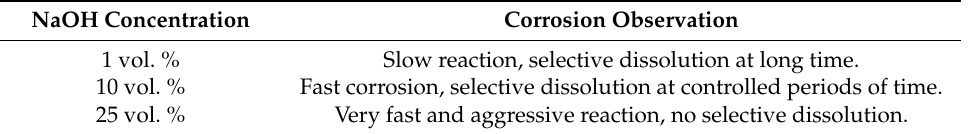
Table 2. Observed reactions for samples directionally solidified in NaOH at different concentrations. NaOH Concentration Corrosion